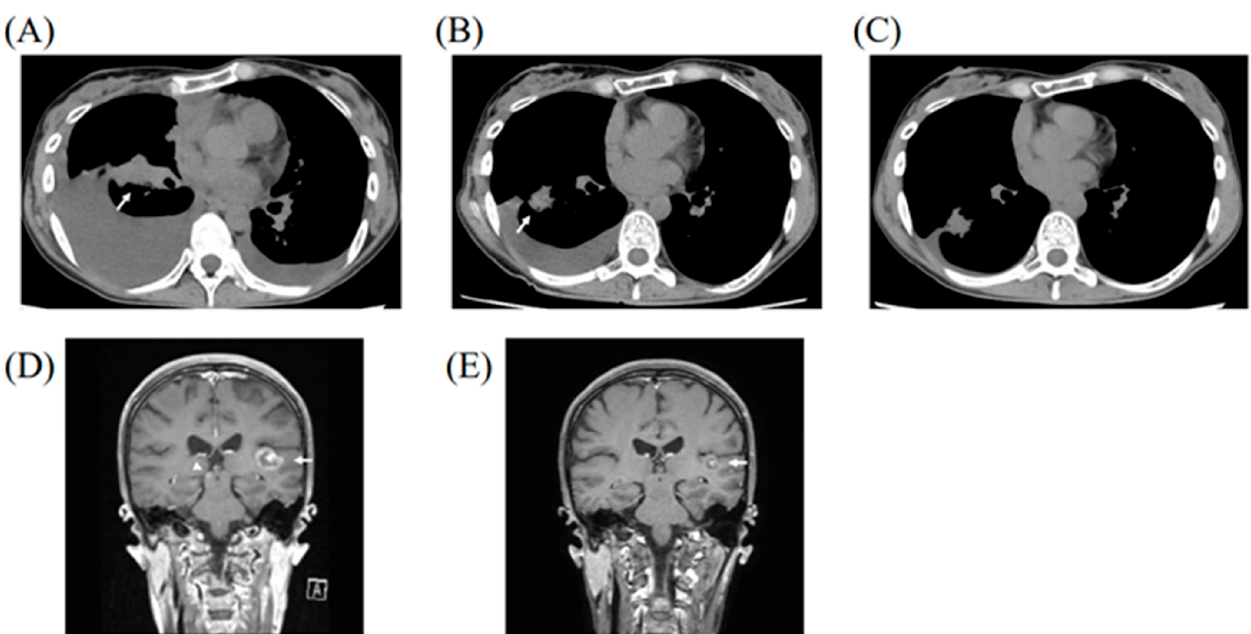
Figure 2. Chest computed tomography taken 25 days after initiation of osimertinib treatment showed shrinkage of the primary lesion (arrow), with increased right pleural effusion ( A ). The primary lesion (arrow) continued shrinking after three months of treatment, with right pleural effusion decreased in amount ( B ), which almost disappeared seven months after treatment ( C ). Multiple brain metastases also showed significant shrinkage in the left temporal lobe (arrow) and right midbrain (arrowhead), with a disappearance in the remaining lesions after 24 days ( D ). Further shrinkage of the brain metastases was observed after three months ( E ).